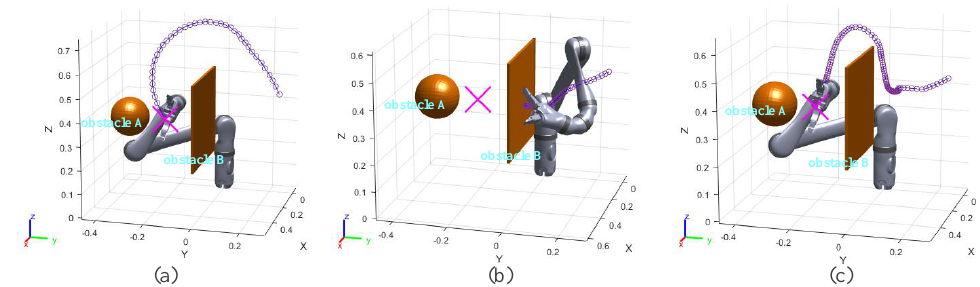
Figure 5. Experiments B: the distance between the robot arm and the target point and obstacles.